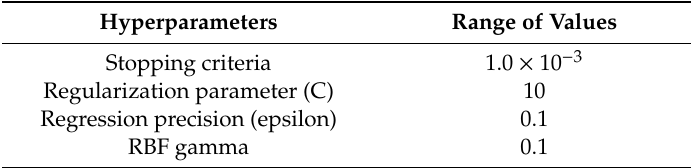
Table 2. Hyperparameters of SVM used for the current